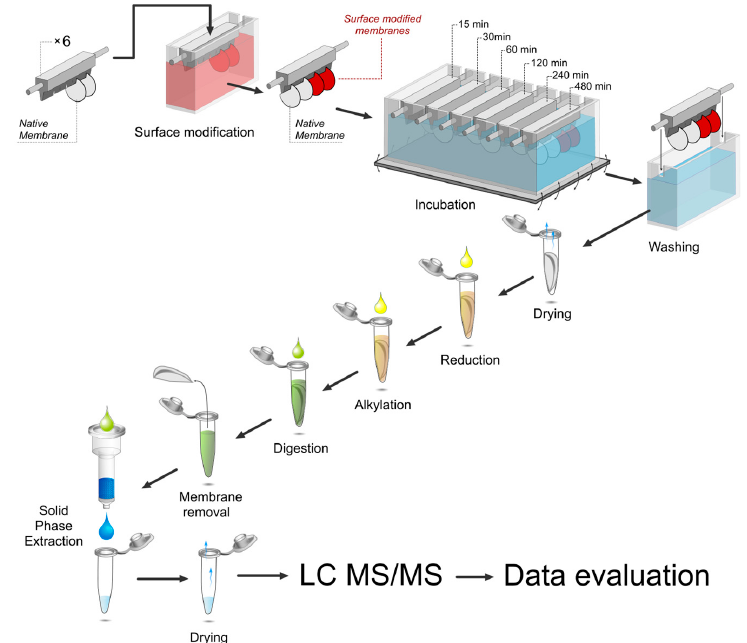
Figure 1. Schematics of the experimental set-up for studying protein adsorption to native and coated microdialysis membranes using LC-MS/MS. Native and coated membranes were processed side by side to control the experimental variation.